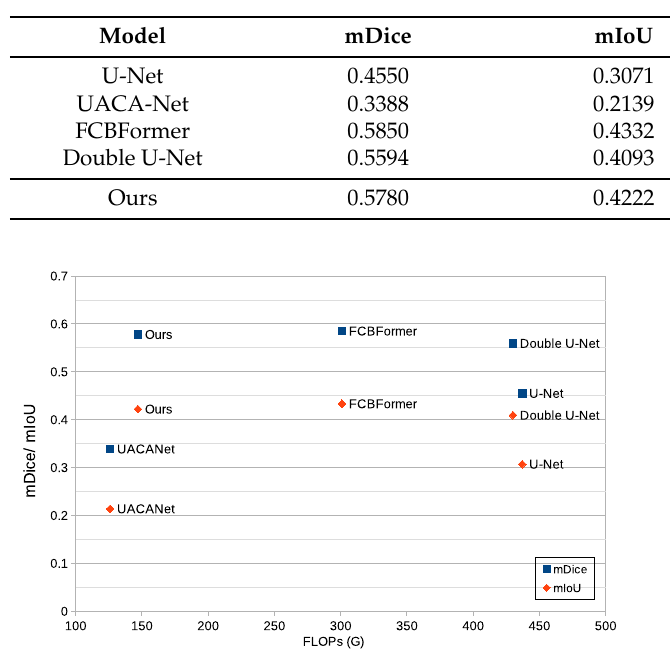
Table 2. Performance and computational complexity comparison to the state-of-the-art and ours.